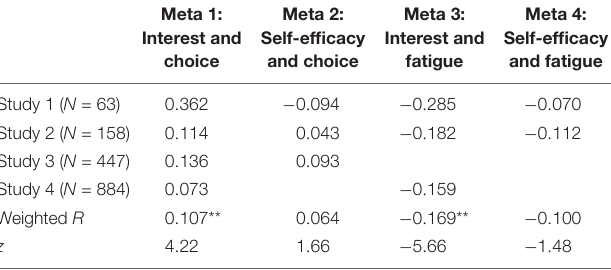
TABLE 3 | Internal mini meta-analysis of four